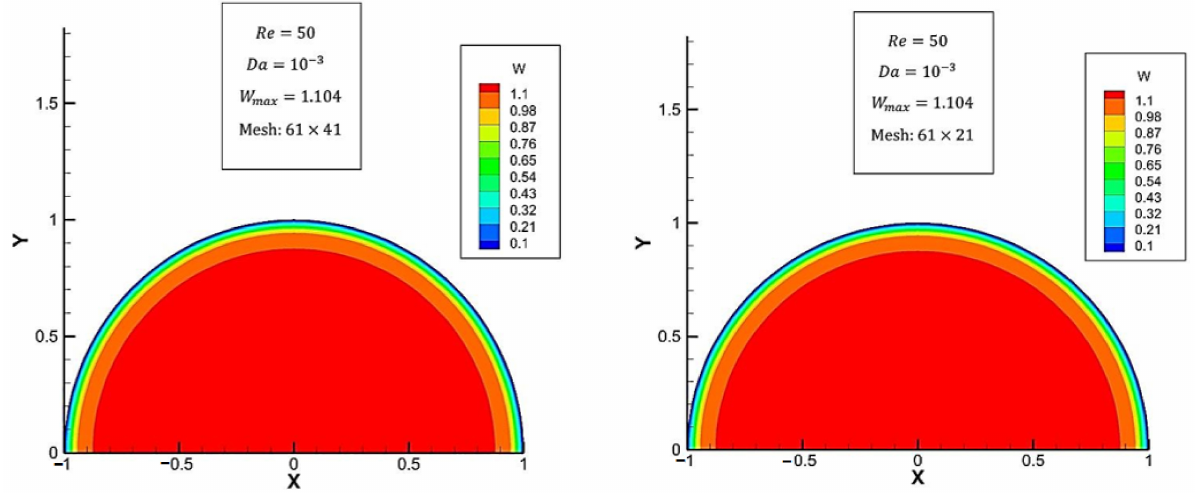
Figure 9. The developed velocity contours in a tube completely filled with a porous medium for two different